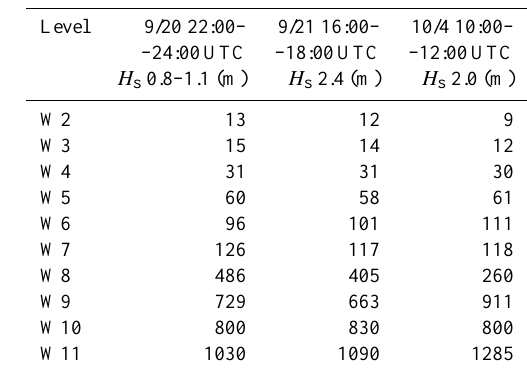
Table 2. Wavelet level dominant periods in